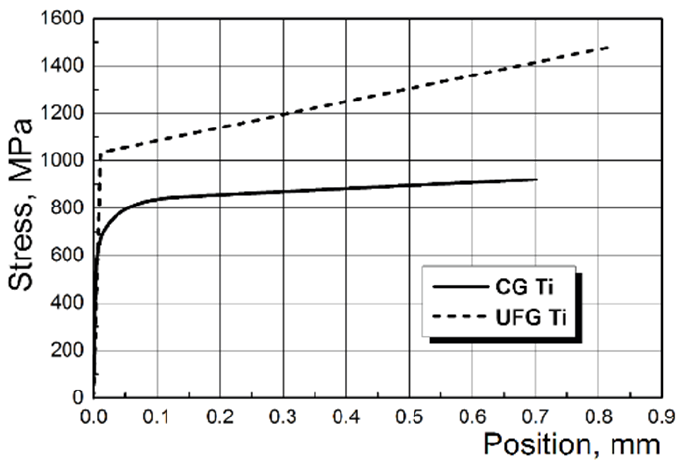
Figure 3. Titanium deformation curves used to determine the elasto-plastic models of titanium. The interaction between the components of a model was considered through the creation of respective models of junctions (contact pairs). For the screw–bone interfaces, a bonded contact type was specified that implied a rigid connection between the finite elements in the interface surfaces of the mating bodies. For the screw–plate, plate–bone, and bone–finger interfaces, a standard (sliding) contact with friction was specified. The friction coefficients are presented in Table 2. Table 2. Friction coefficients for